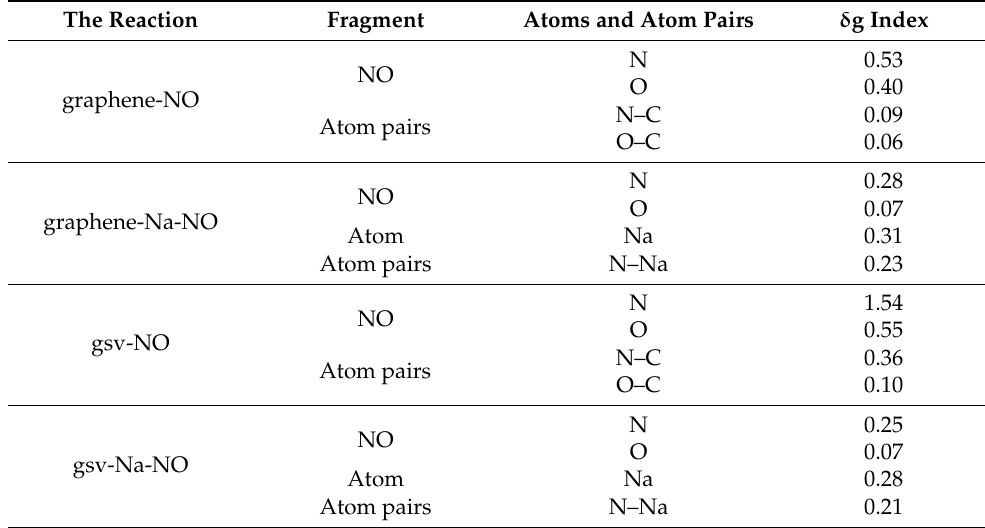
Table 2. The δ g index of atoms and atom